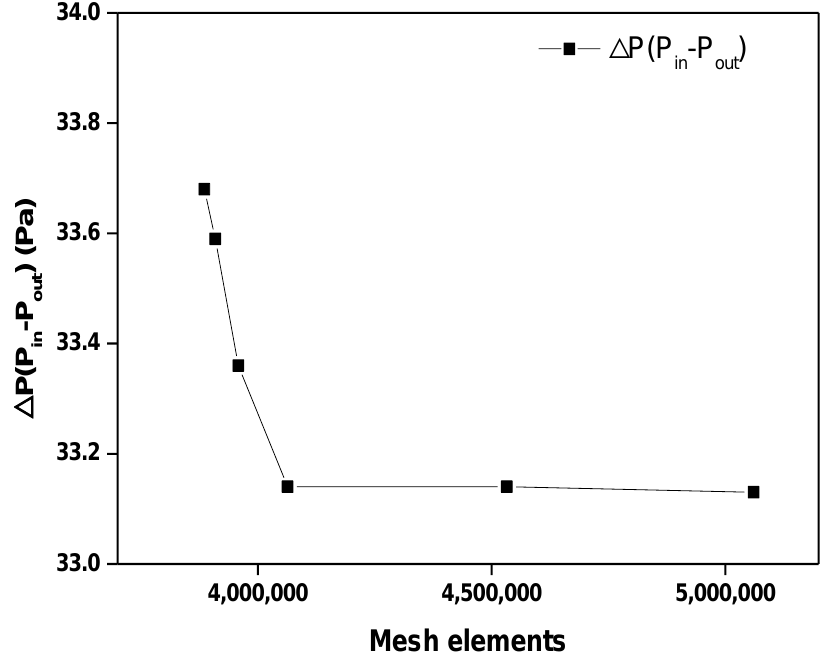
Figure 3. Grid independence according to mesh elements.